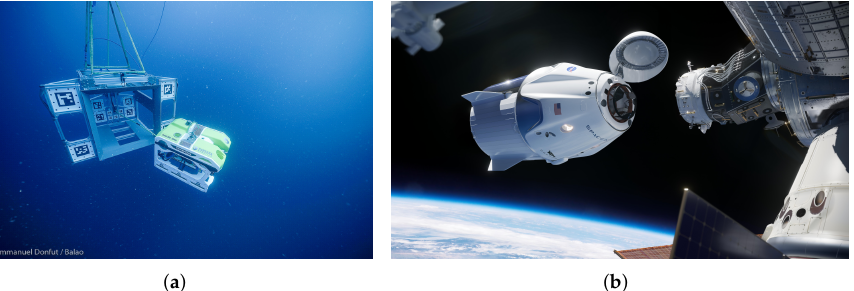
Figure 1. Rendezvous missions. ( a ) Recovery of a ROV (courtesy of Forssea Robotics). ( b ) Spacecraft docking (copyright free picture from